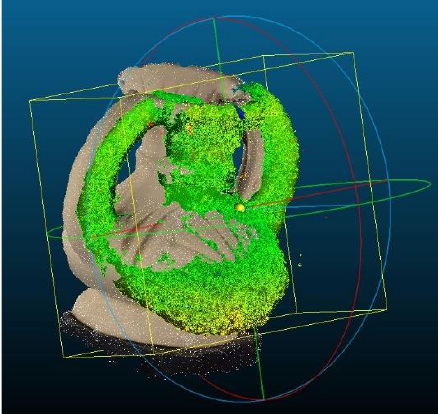
Figure 13. View of the merged models after texture mapping and calculation of standard deviation.